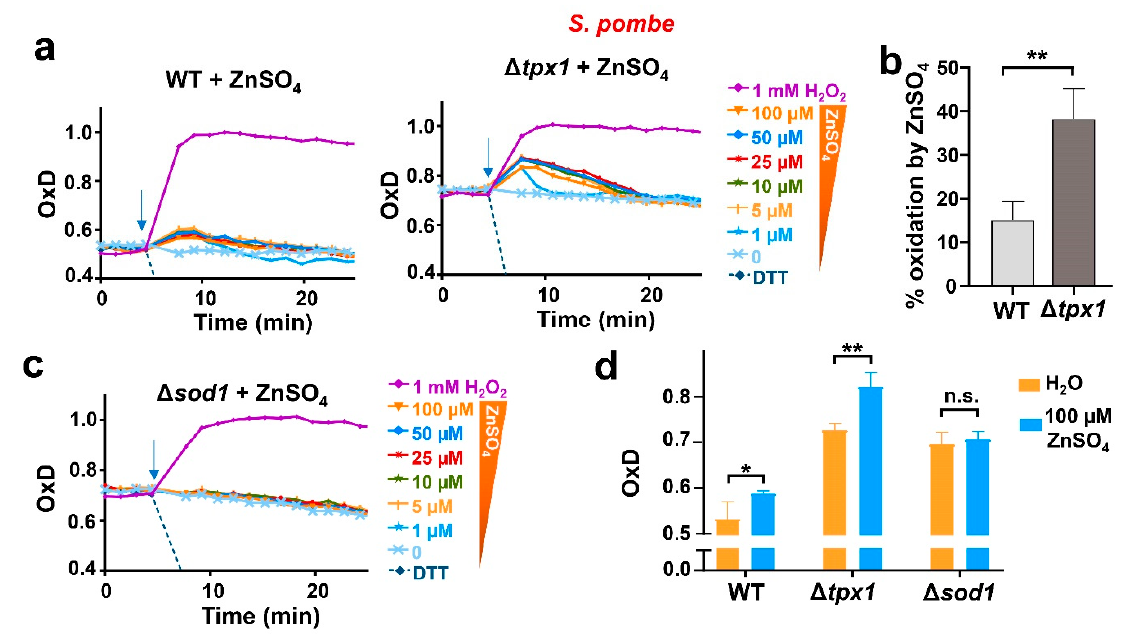
Figure 4. In fission yeast, non-toxic levels of zinc cause a sudden H 2 O 2 burst which depends on the presence of Sod1. ( a,c ) Cultures from strains ( a ) HM123 (WT), SG5 ( Δ tpx1 ), and ( c ) JM18 ( Δ sod1 ), transformed with p407.C169S to express roGFP2-Tpx1.C169S, were grown, treated, and processed as described in Figure 3. Average data from three biological replicates are shown, and error bars (S.D.) are displayed in Figure S3. In all graphs, the time of addition is indicated with arrows. ( b ) Percentage of probe oxidation upon 100 µM ZnSO 4 in WT and Δ tpx1 at the first time point after treatment as shown in (a). Y-axis: the 0–100% oxidation of the biosensor in each background was determined using the OxD 0 of each strain as 0% and 1 mM H 2 O 2 of each strain as 100%. ( d ) The bar graph represents the OxD values of the strains in (a) and (c), at time 0 (orange bars) and at the first time point after treatment with 100 µM ZnSO 4 (blue bars). Statistical significance was calculated with a ratio paired Student’s t-test between indicated samples with p -values of 0.05 (*) and 0.01 (**); n.s., non-significant.